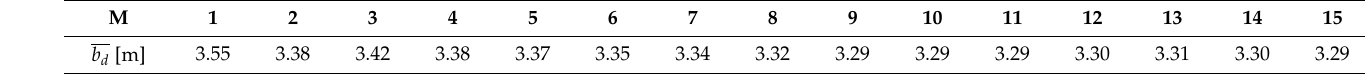
Table 8. The mean error of the position estimation for different widths M of the moving window.